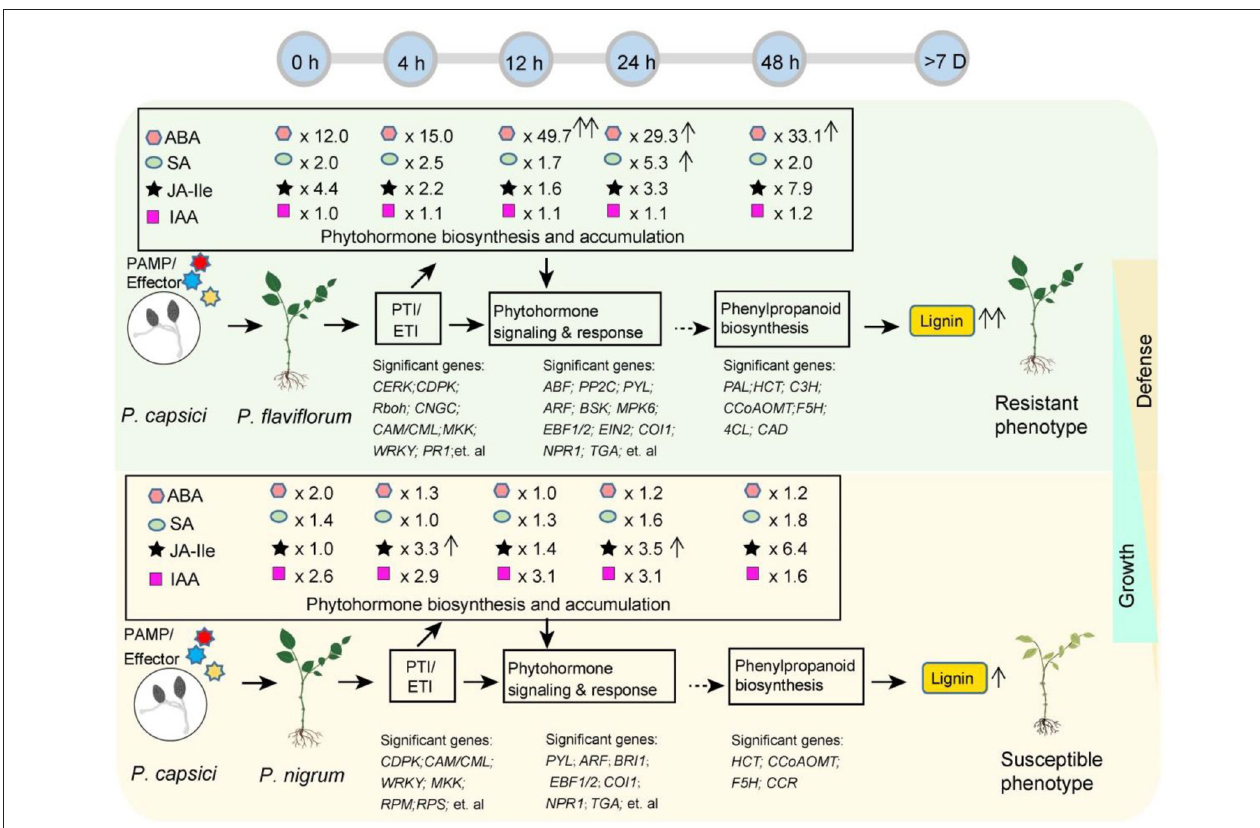
FIGURE 6 | Schematic summarizing the different transcriptome and metabolome profiles in resistant P. flaviflorum and susceptible P. nigrum upon P. capsici infection. Significant differences were observed in the expression of PTI and EIT pathway genes, endogenous phytohormone levels, phytohormone signaling and response, and also in the downstream phenylpropanoid biosynthesis pathway and lignin levels, leading to different postinfection phenotypes in resistant vs. susceptible Piper . Time-course ABA, SA, JA-Ile, and IAA levels were normalized and are presented as the relative content in resistant Piper compared with susceptible Piper ; arrows after relative ratios indicate a significant increase ( P < 0.05) in phytohormone levels at the indicated time point relative to 0h for that